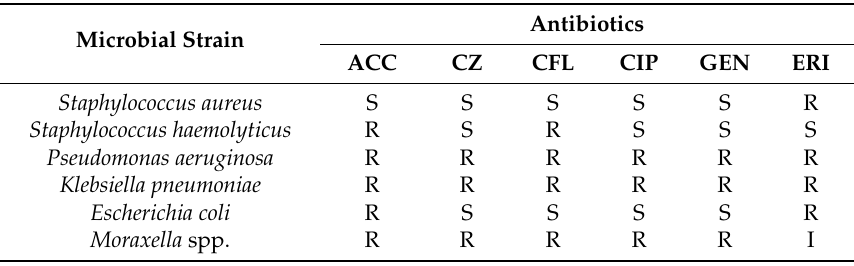
Table 8. Antibacterial sensitivity of the strains of microbes used in the study. Antibiotics Microbial Strain ACC CZ CFL CIP GEN